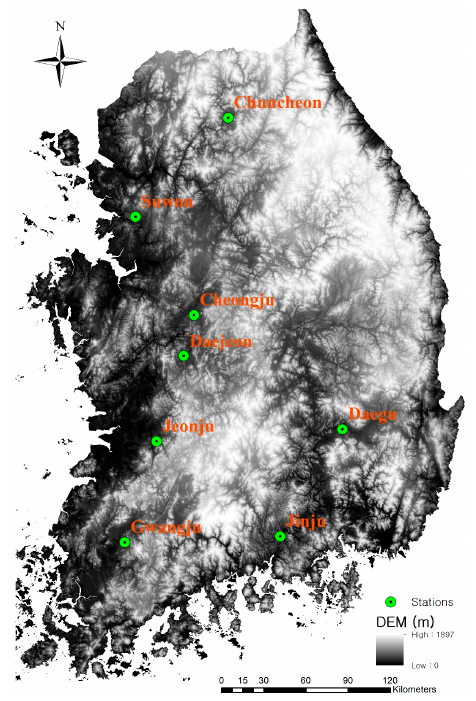
Figure 2. Locations of the eight meteorological stations.